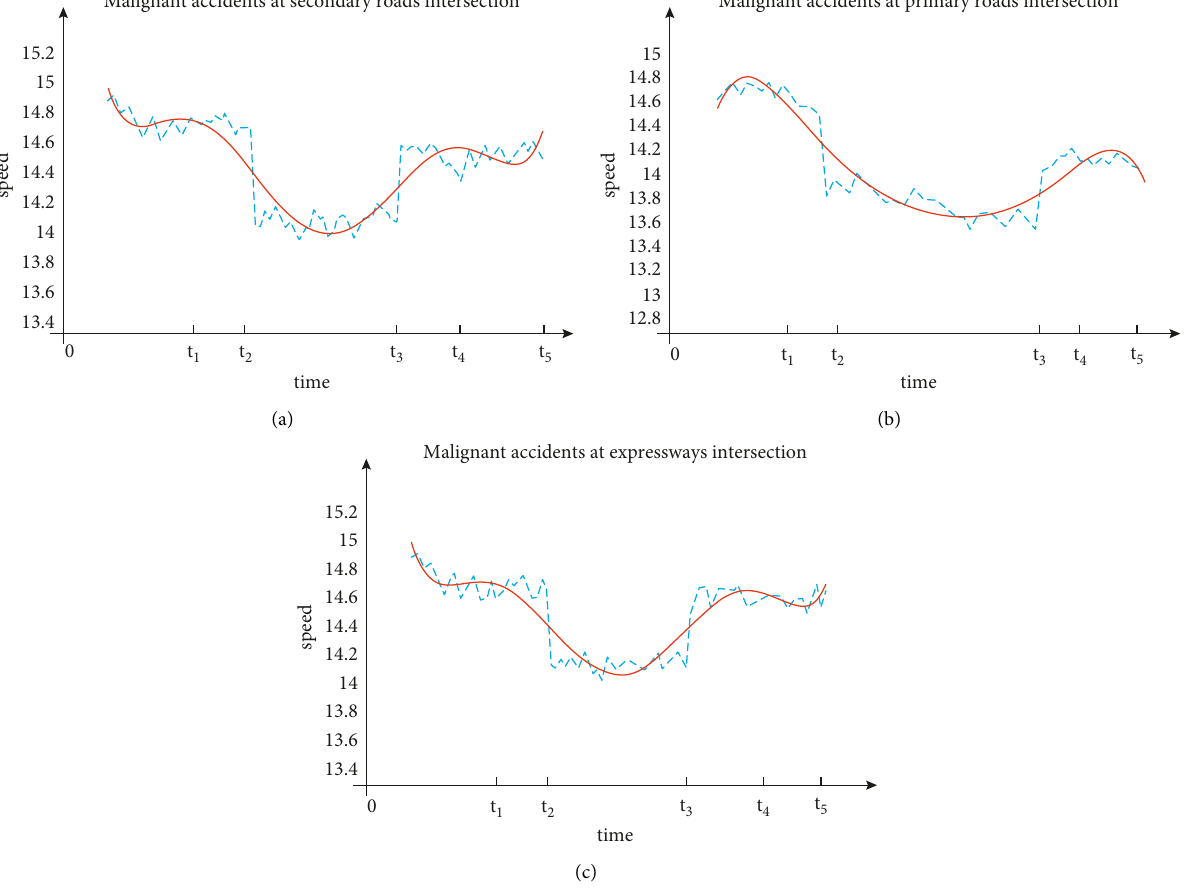
Figure 4: Time distribution of network average speed with malignant accidents at (a) secondary roads intersection, (b) primary roads intersection, and (c) expressways